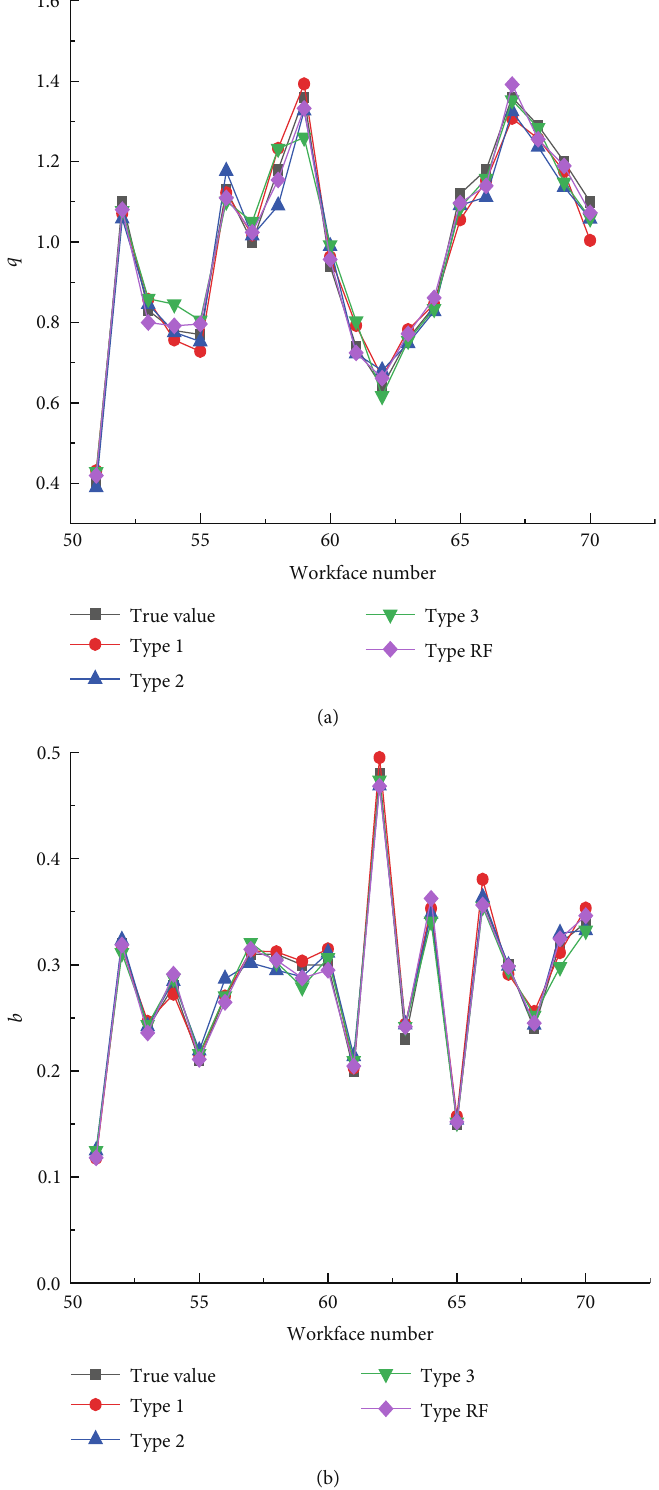
Figure 11: PIM parameter prediction results under di ff erent input layer